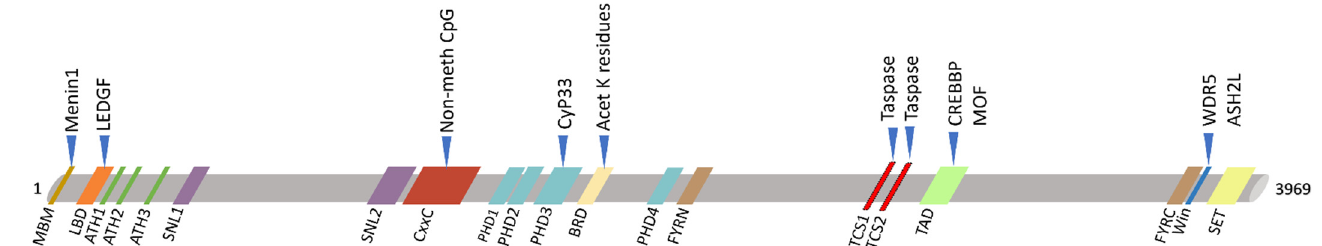
Figure 3. Schematic view of KMT2A protein domains (below) and its main interactors (upper). KMT2A domains: MBM, high-affinity Menin-binding motif, residues 6–10; LBD, LEDGF-binding domain, residues 109–153; ATH1-2-3, AT-Hook1/2/3, residue 169–180, residues 217–227, residue